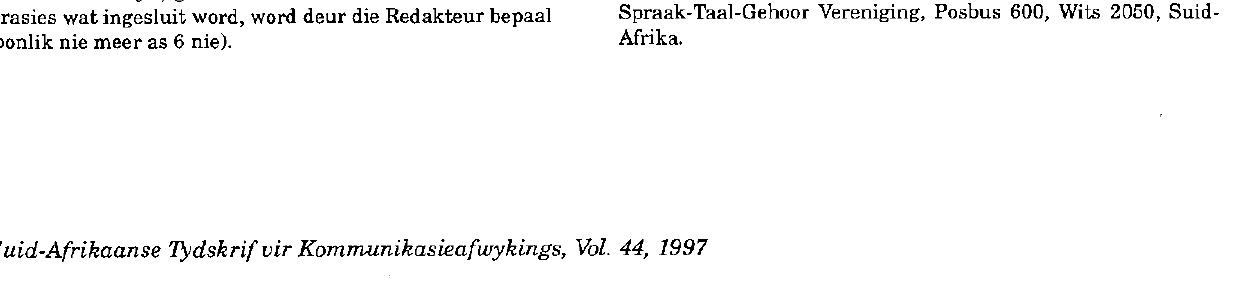
TABELLE EN FIGURE wat op afsonderlike bladsye (een bladsy per tabel/illustrasie) moet verskyn, moet vir referent-doeleindes gekopieer word en slegs die kopiee moet inisieel verskaf word. Figure, grafieke en lyntekeninge wat vir publikasie gebruik